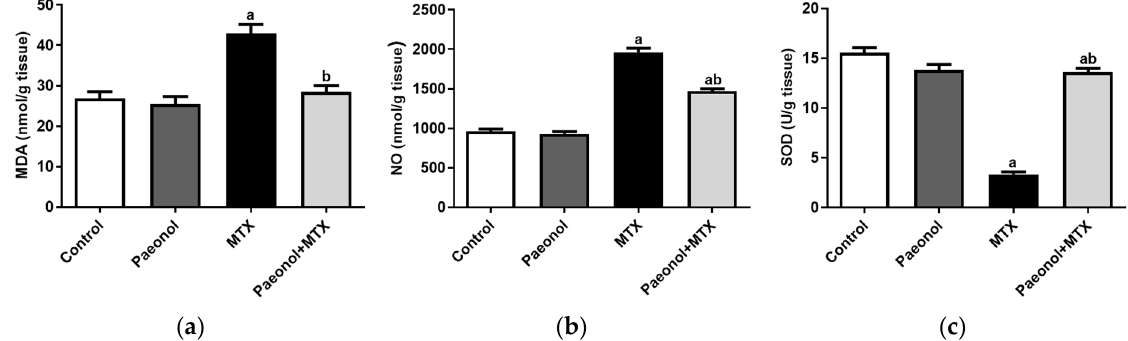
Figure 2. The effect of paeonol on hepatic ( a ) lipid peroxide malondialdehyde (MDA), ( b ) nitric oxide (NO), and ( c ) superoxide dismutase (SOD) in MTX-induced hepatotoxicity in rats. Data represent the mean ± SEM of 6 observations. Letters a,b Denote significant differences from the normal control and the MTX groups, respectively, at p ˂ 0.05.